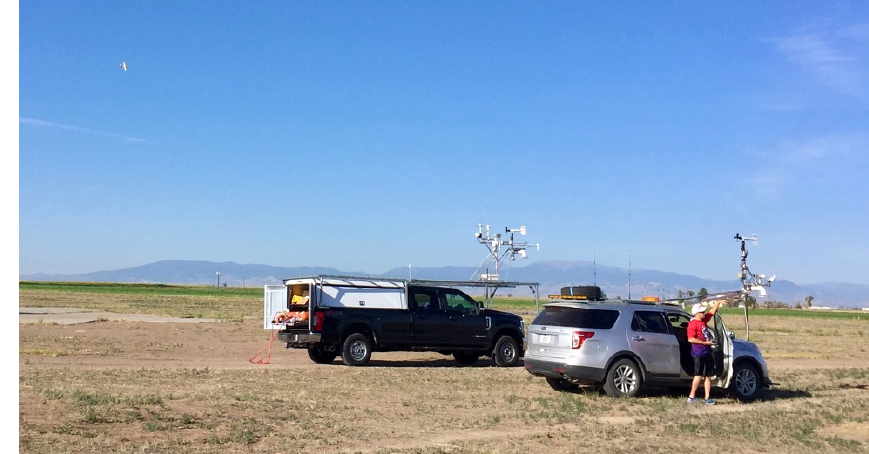
Figure 4. The NSSL MM and UNL CoMeT deployed side-by-side for an on-site intercomparison. The CU MURC was also located on site, but out of the photograph, and a CU TTwistor UAS (see de Boer et al., 2020c, in this special issue) flies in the background.